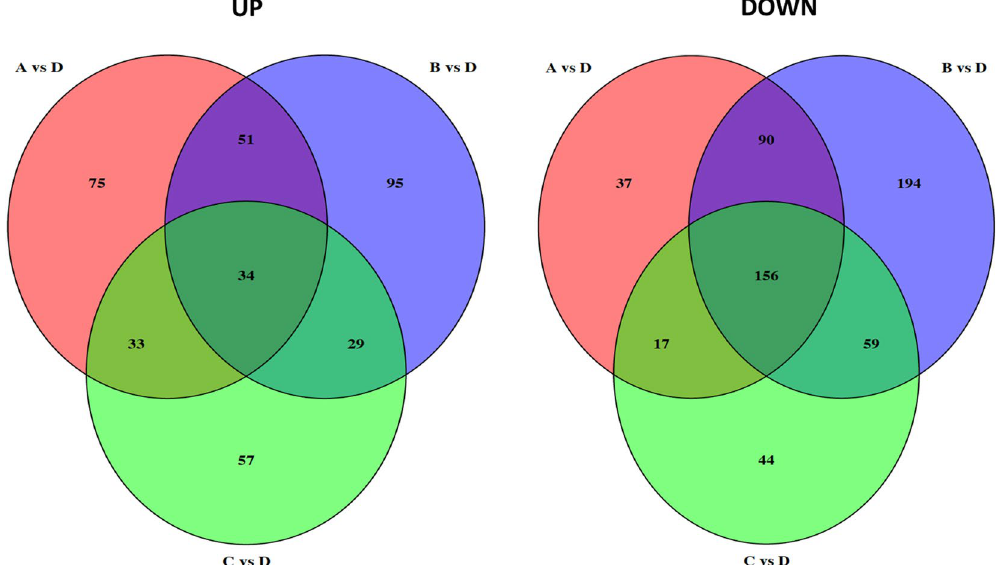
Figure 2. Venn diagram depicting the number of differentially up-regulated genes (left) and down-regulated genes (right) identified from Conditions A, B, and C compared to Condition D. Numbers in overlapping regions denote genes shared between the different comparisons and numbers in non-overlapping regions denote genes unique to each comparison. See Table 1 for description of the